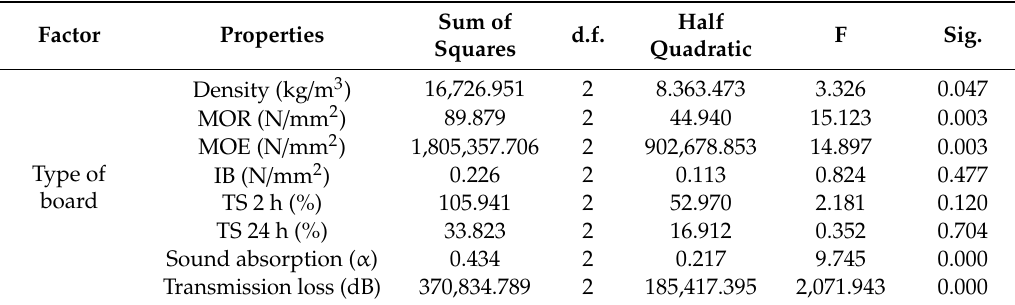
Table 5. ANOVA of the results of the